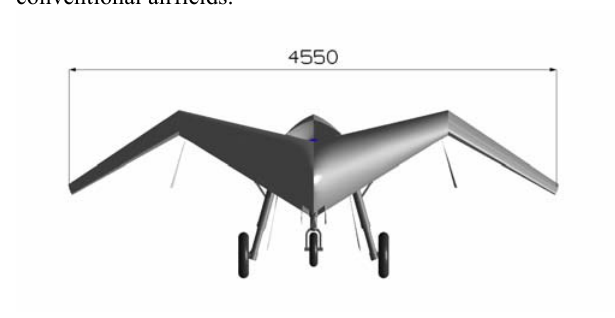
Fig 5. PW-124 – front view (span in [mm])